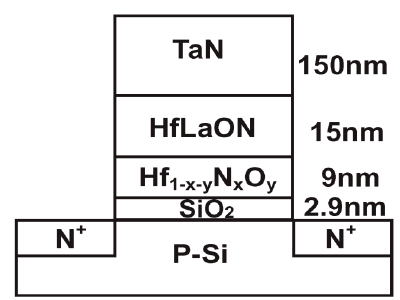
Figure 7. TaN/HfLaON/Hf Reused with permission from [41], Copyright 2008,